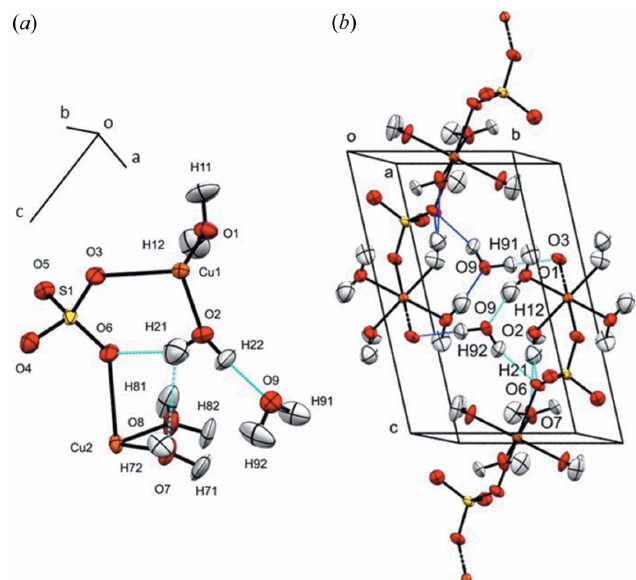
Figure 8 ( a ) Labelling of atoms and hydrogen-bonds (blue dotted lines) in the asymmetric unit of copper sulfate pentahydrate at 0.71 GPa. ( b ) Hydrogen bonding of the sample as viewed along a *. Ellipsoids are shown at 50%